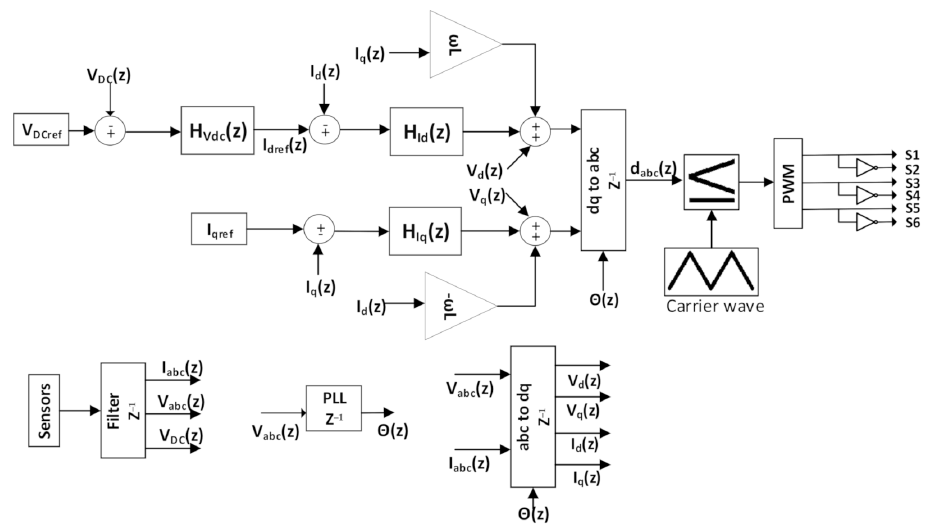
Figure 10. Digital control FPGA